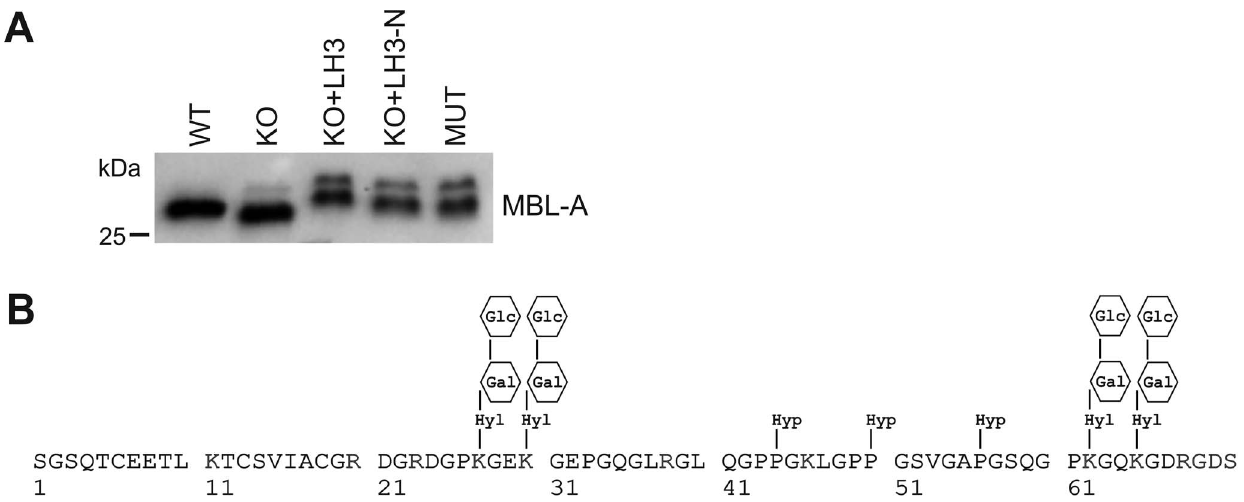
Figure 1. Immunoblot analyses of rat MBL-A produced in LH3 manipulated cell lines. (A) The immunoblot analysis of recombinant rat MBL-A monomers from the concentrated medium of wild type, LH3 2 / 2 knockout and LH mutant MEF cells suggests differences in posttranslational modifications of MBL-A. Production of MBL-A with the full length LH3 or the amino-terminal fragment of LH3 restored the mobility shift on SDS-PAGE. The MBL-A produced with LH3 had a higher molecular weight than wild type protein, suggesting overglycosylation of lysines. Representative samples are shown. (B) Schematic picture of the collagenous domain of rat MBL-A shows the positions of posttranslational modifications of lysine and proline residues reported earlier. Abbreviations: WT 5 wild type; KO 5 LH3 2 / 2 knockout; LH3 5 full length LH3; LH3-N 5 amino-terminal fragment of LH3; MUT 5 LH mutant; Hyl 5 hydroxylysine; Gal 5 galactosyl; Glc 5 glucosyl; Hyp 5